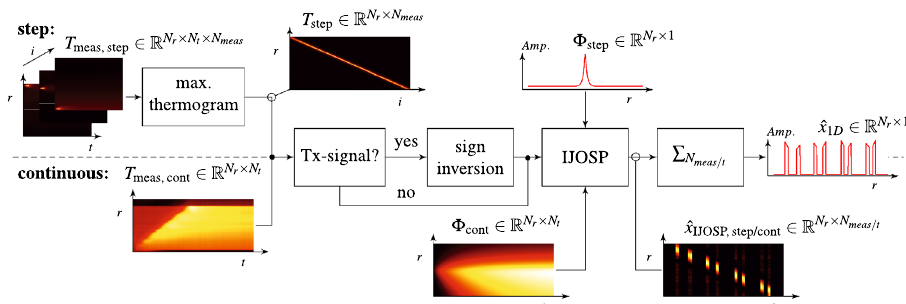
Figure 4. Flow chart depicting the data analysis procedure discussed in this work. The chart is split in two halves by a dashed line: the bottom half describes the necessary steps for continuous scanning data, while the top half shows the steps for data generated by step scanning. The direction of data flow is from left to right. The inspection of intermediate results is marked by empty circles. Tx = Transmission, T step N t � cont � 1 , . . . , � cont ] cont := [